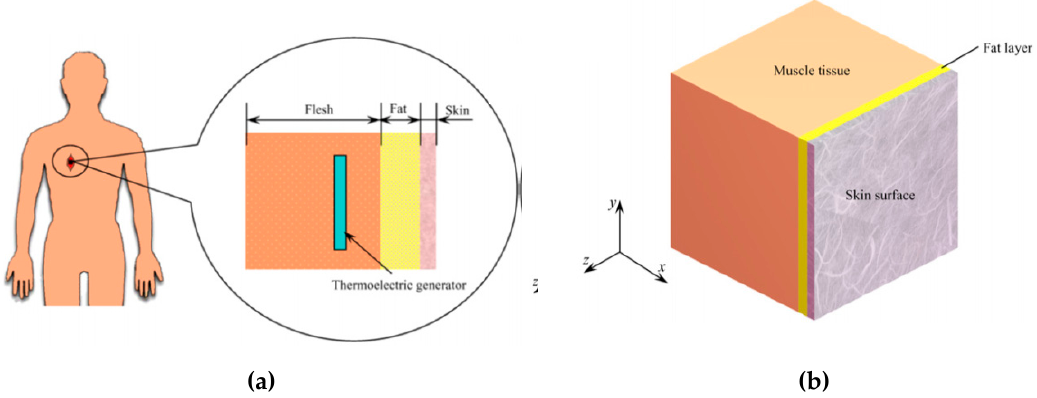
Figure 14. ( a ) TEG embedded in three-layer human tissue; ( b ) cubic domain of human tissue